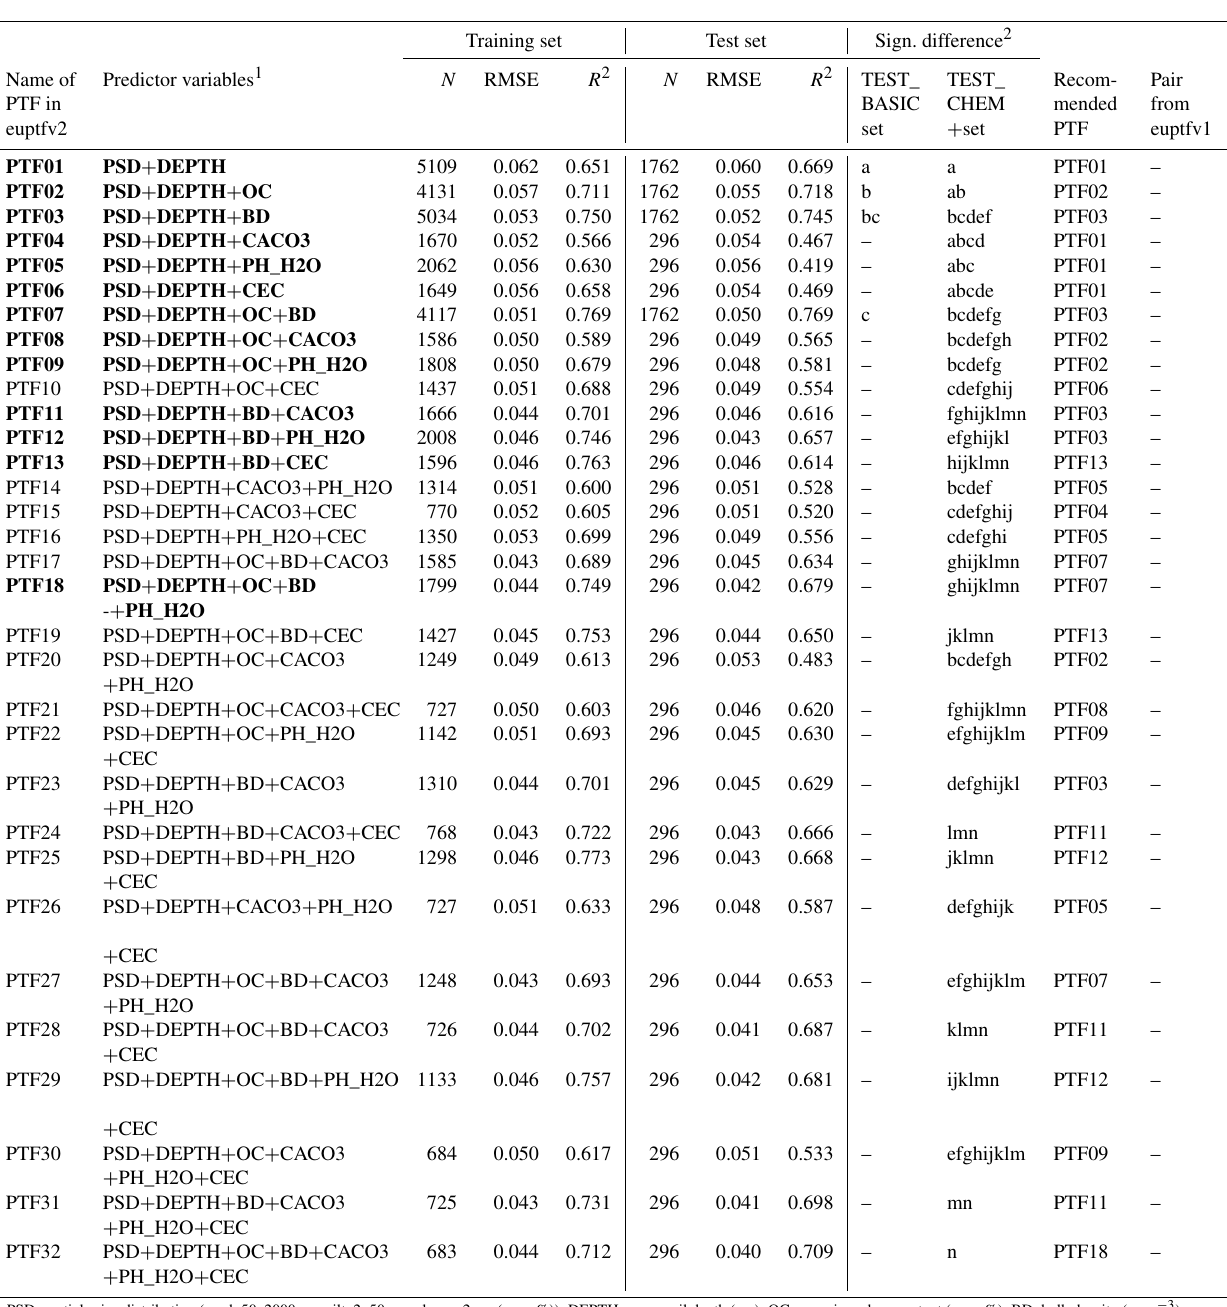
Table 3. Performance of pedotransfer functions (PTFs) by input combination on training and test datasets to predict water content at − 100cm matric potential head (FC_2). N : number of samples, RMSE: root mean square error (cm 3 cm − 3 ), and R 2 : determination co- efficient, TEST_BASIC: samples with measured PSD, DEPTH, OC and BD; TEST_CHEM + : samples with measured PSD, DEPTH, OC, BD, CACO3, PH_H2O and CEC. Recommended PTFs are highlighted in bold. FC_2 was not analysed in